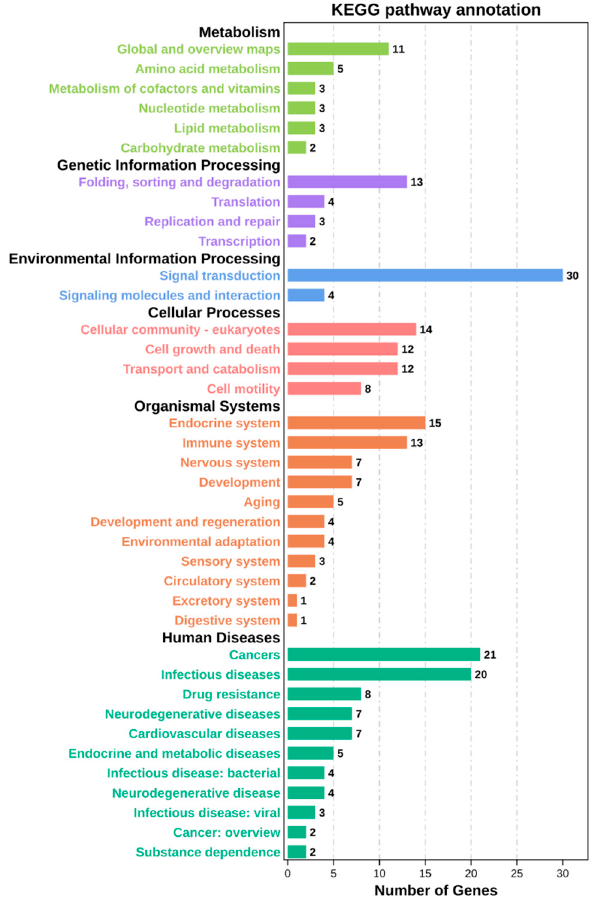
Figure 4. KEGG pathways of differentially expressed genes.